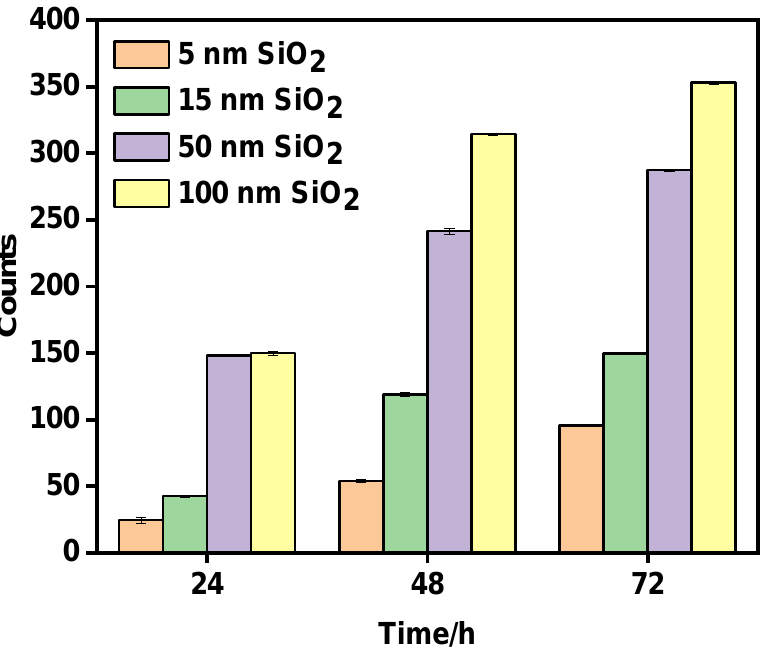
Figure 2. Histogram of the number of crystals with SNP of different sizes as a function of time. Conditions: 0.05 M, pH 4.5 sodium acetate buffer solution, 3 wt.% sodium chloride, 15 mg/mL lysozyme at 4 ◦